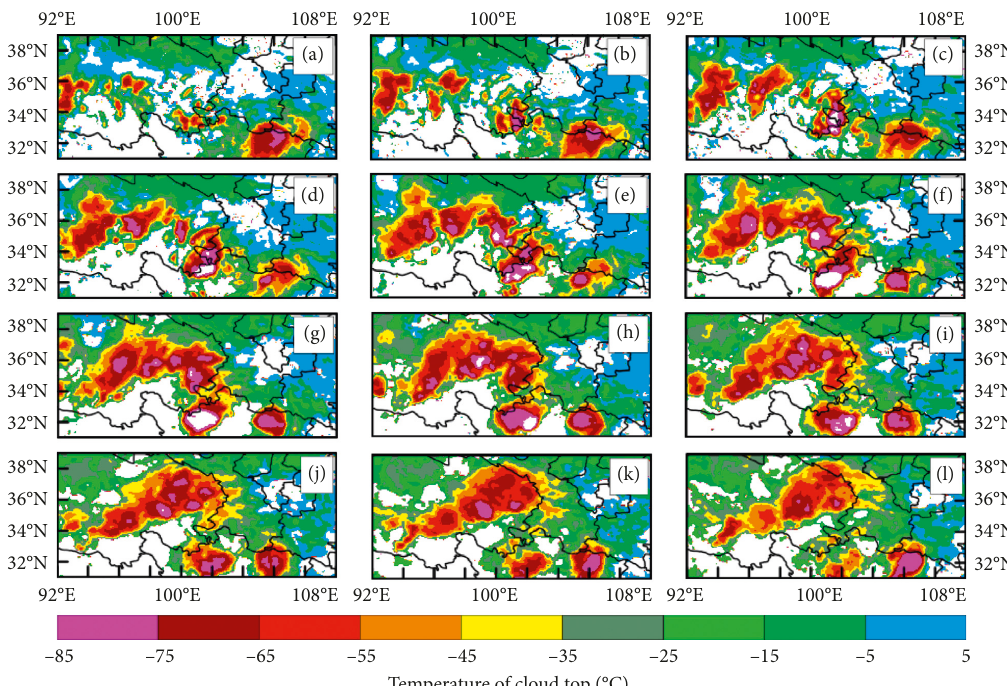
Figure 3: FY-2F cloud top temperatures on June 27, 2015 (unit: ° C): (a) 07:00 UTC; (b) 08:00 UTC; (c) 09:00 UTC; (d) 10:00 UTC; (e) 11:00 UTC; (f) 12:00 UTC; (g) 13:00 UTC; (h) 14:00 UTC; (i) 15:00 UTC; (j) 16:00 UTC; (k) 17:00 UTC; (l) 18:00 UTC.